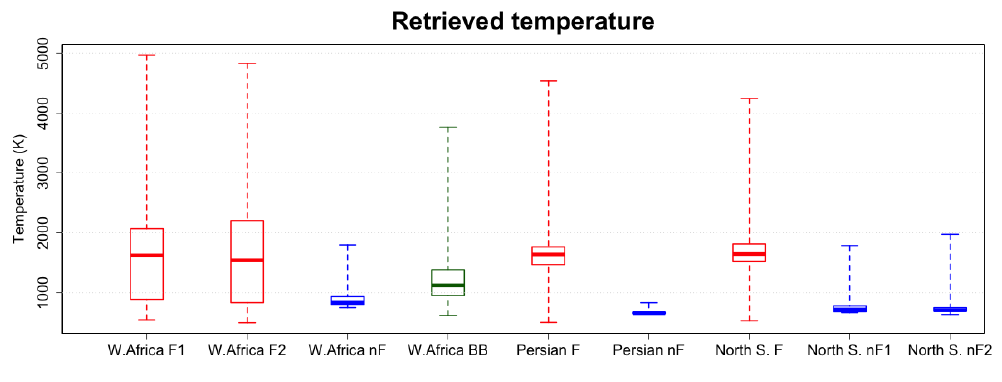
Figure 10. Temperature retrievals distribution for the hot spots within each study area defined in Figure